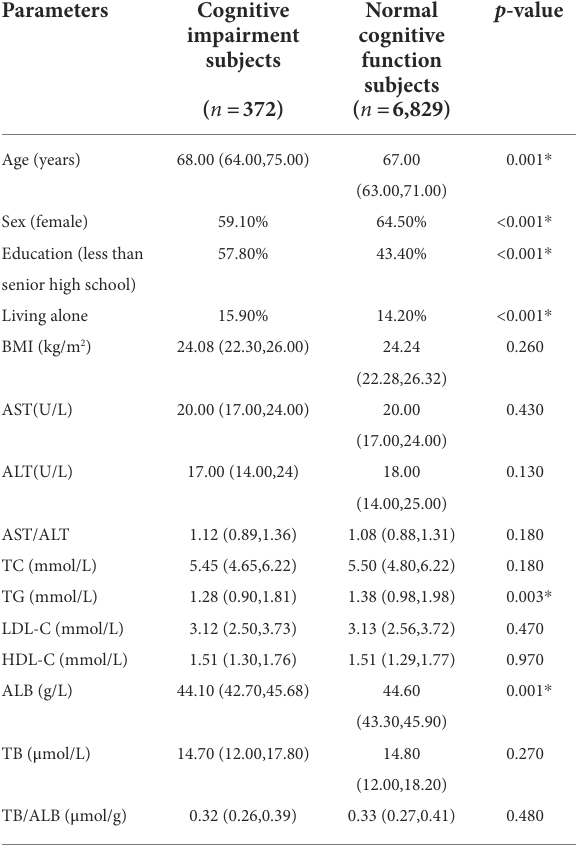
TABLE 1 Demographics and laboratory parameters of the study population.